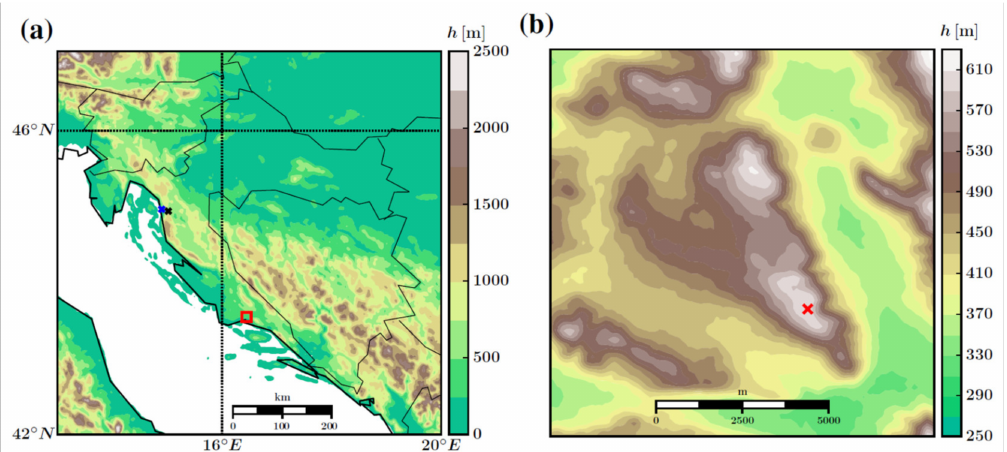
Figure 1. ( a ) Map of Croatia and a part of the Adriatic Sea. The square in ( a ) marks in the area ( b ) around the location of Pometeno Brdo (Swept − Away Hill); the cross in ( b ) shows the meteorological tower position. The colour bars denote height ASL in m. The other marks in ( a ) show the location of the town of Senj (NW from ( b )), famous for bora severe wind, and Vratnik Pass, respectively. (Reprinted from ref.